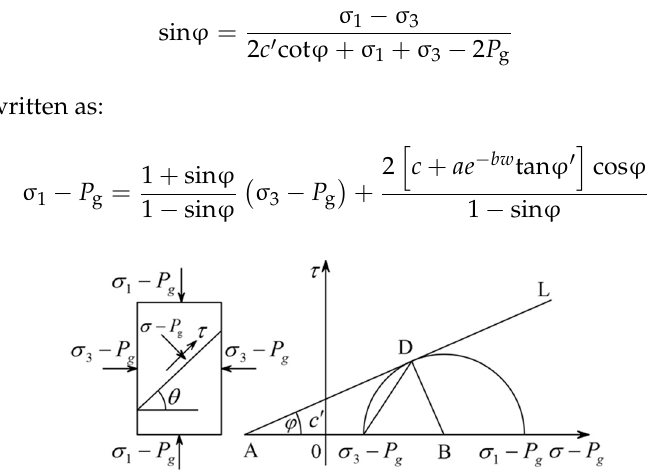
Figure 7. Strength criterion shown in (( σ − P g ), τ ) coordinates.